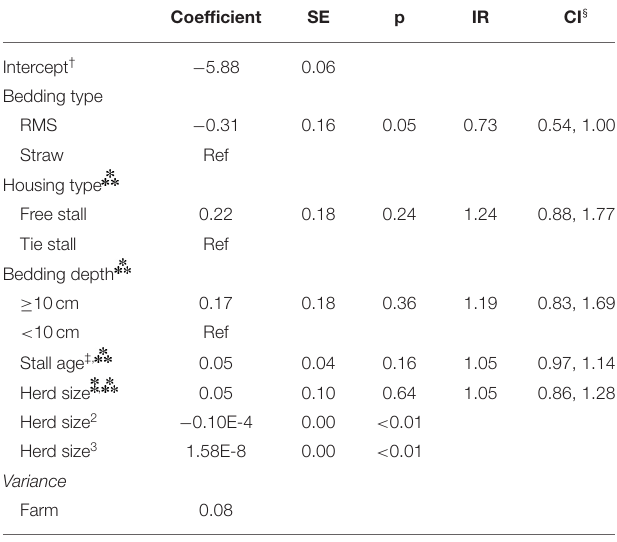
TABLE 4 | Risk of acquiring a new subclinical mastitis as function of bedding type estimated using a generalized linear mixed model applied to 43,546 pairs of DHI tests from 11,031 cows from 20 RMS farms and 60 straw-bedded